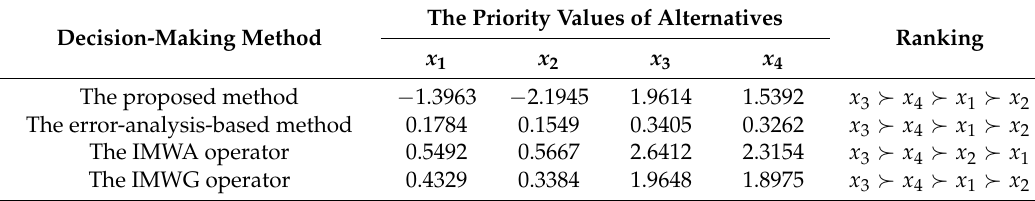
Table 2. Comparison result of Example